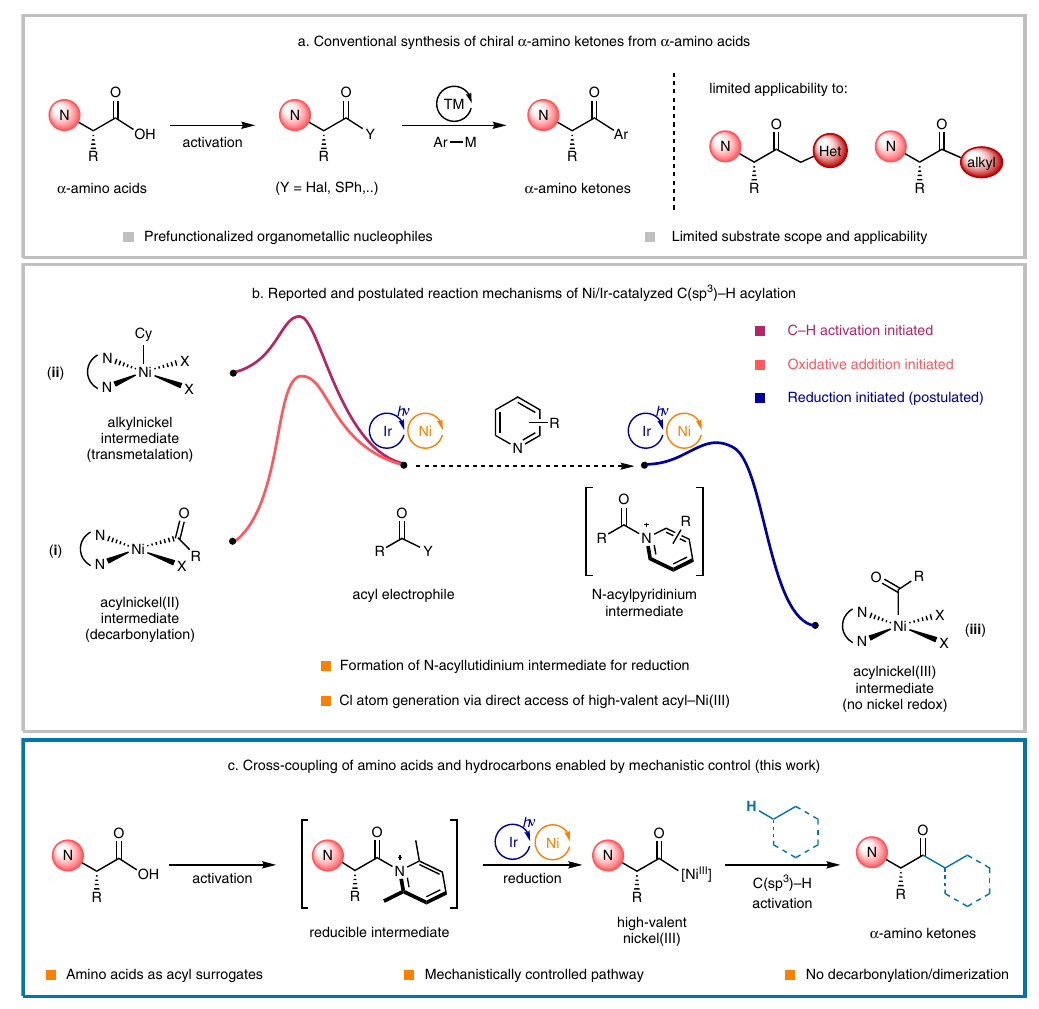
Fig.1|Challengesandstrategyforthecross-couplingofchiralaminoacidsand hydrocarbons. a Conventionalsynthesis of chiral α -aminoketones from α - aminoacids. b ReportedandpostulatedreactionmechanismsofNi/Ir-catalyzed